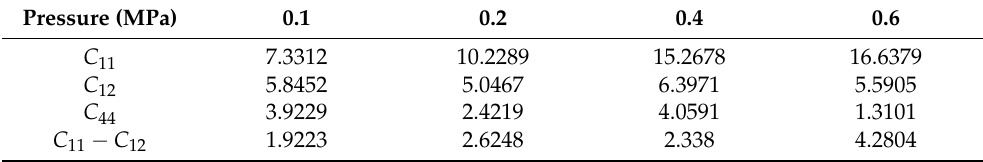
Table 3. Elastic stiffness constants of the cellulose amorphous region for different pressures. Pressure (MPa) 0.1